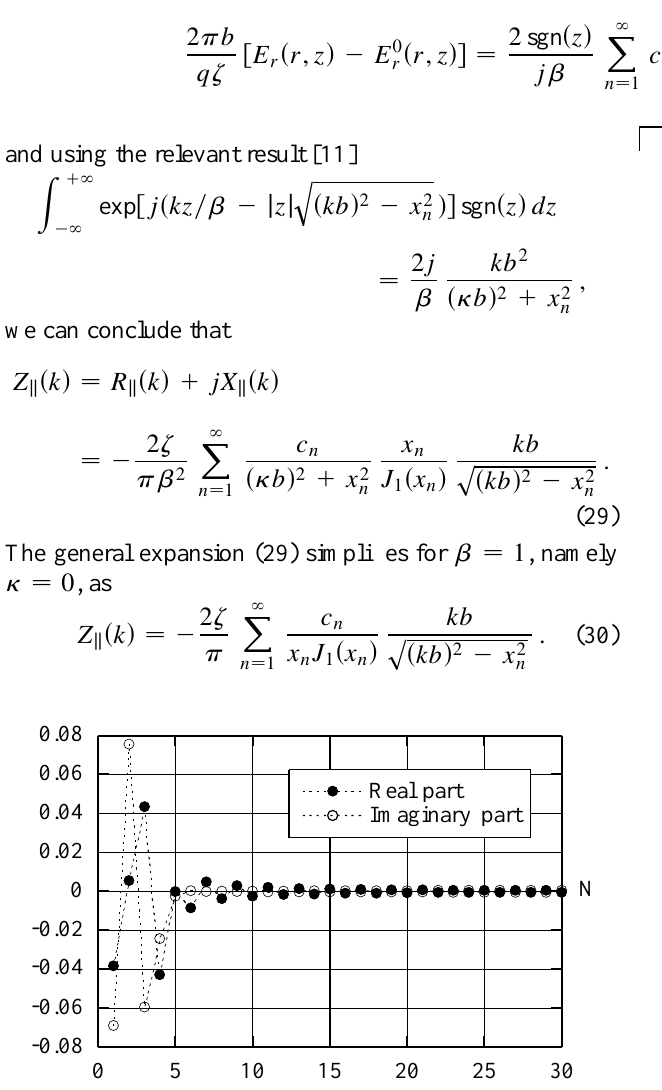
FIG. 4. Expansion coefficients (cid:102) (cid:78) versus (cid:78) in the case (cid:107)(cid:98) (cid:173) (cid:49)(cid:48) , (cid:119) (cid:173) (cid:52) (cid:121) (cid:53) , and b (cid:173) (cid:49)